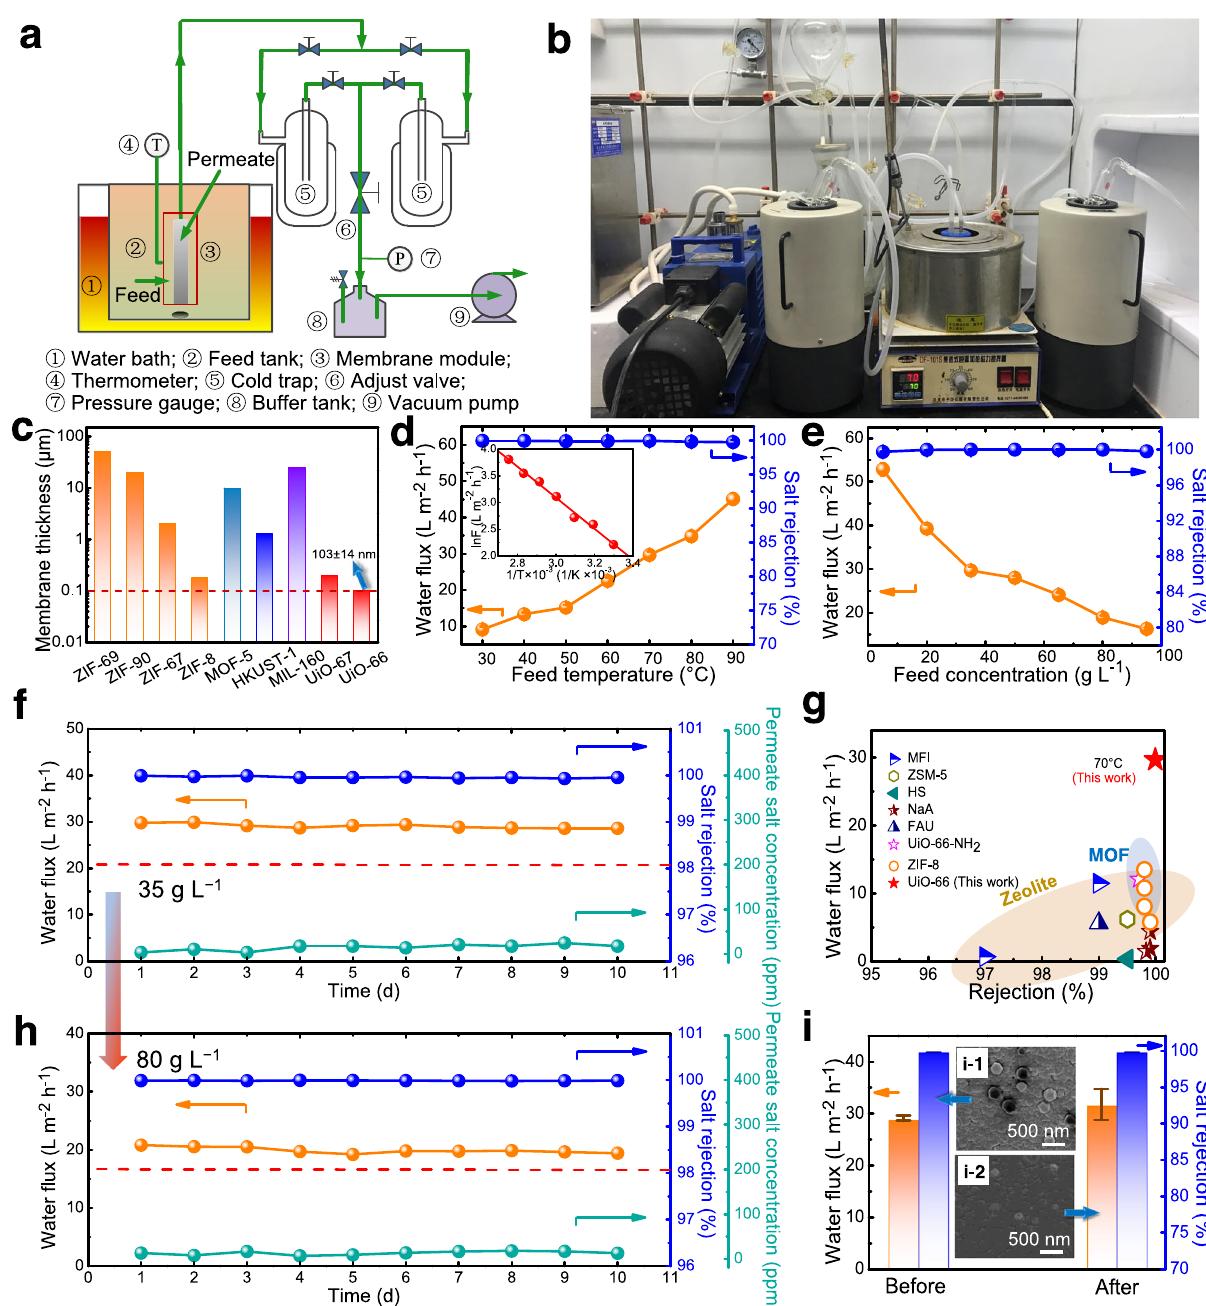
Fig. 3 Desalination performance of robust ultrathin UiO-66/ML-UiO-66 membranes. a Schematic diagram and ( b ) photograph of a PV setup for testing UiO-66/ML-UiO-66 membranes fabricated in this work. c Comparison of membrane thickness via a solution-based solvothermal method between UiO-66 membrane fabricated in the current study and other MOF membranes with lowest thickness reported in the literature 63 – 70 . d Water fl ux and salt rejection as a function of feed temperature during the PV process (35 g L − 1 NaCl solution) (the inset shows an Arrhenius plot between water fl ux and reciprocal of feed absolute temperature). e Water fl ux and salt rejection as a function of feed salt concentration ranging from 5 g L − 1 to 95 g L − 1 at a constant feed temperature of 70 °C. f Long-term operating desalination performance (water fl ux, salt rejection and permeate salt concentration) for the treatment of 35 g L − 1 NaCl solution for 240 h (10 days) at 70 °C without cleaning. (The red dashed lines in Fig. 3f, h represent the limit (Na + < 200 ppm) of drinking- water quality (fourth edition) issued by the World Health Organization (WHO)). g Comparison of water fl ux and rejection between our ultrathin ML-UiO- 66 membrane and other state-of-the-art polycrystalline zeolite and MOF membranes via PV process (See details in Supplementary Table 9). h Long-term operating desalination performance (water fl ux, salt rejection and permeate salt concentration) for the treatment of hypersaline water (80 g L − 1 NaCl solution) for 240 h (10 days) at 70 °C without cleaning. i Water fl ux and salt rejection of ultrathin ML-UiO-66 membranes before and after immersion into NaClO solution (1000 ppm) for 240 h (10 days) for an accelerated chlorine resistance test (the inset shows the FE-SEM images of ML-UiO-66 membrane surface before ( i - 1 ) and after ( i-2 ) the chlorine resistance test). (PV conditions: feed 35 g L − 1 NaCl solution, temperature: 70 °C). (Numbers that follows the ±signs are standard deviation (SD) in this study.).